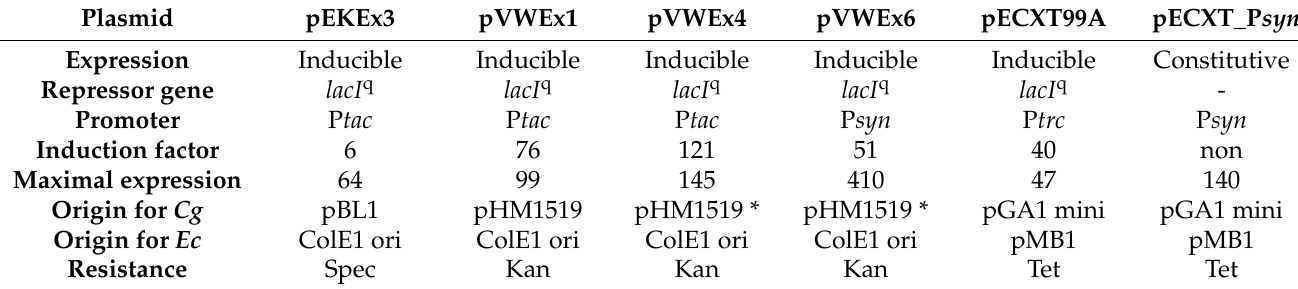
named pVWEx6. This vector allowed for an approximately 50-fold induction with 1 mM IPTG, leading to a maximal norm. MFI of 410 ± 1% (Figure 2 and Table 3). Table 3. Comparison of C. glutamicum expression vectors. *: high-copy number variant of the pHM1519 replicon.